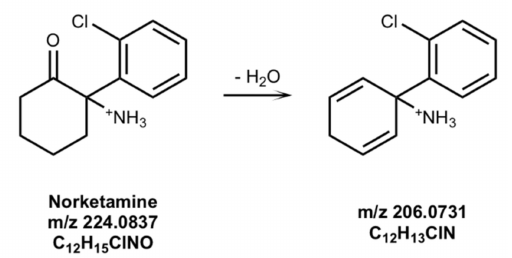
Figure 3. Proposed structures of norketamine (NKET) photoproducts formed in a methanol solution upon irradiation for 3 h.